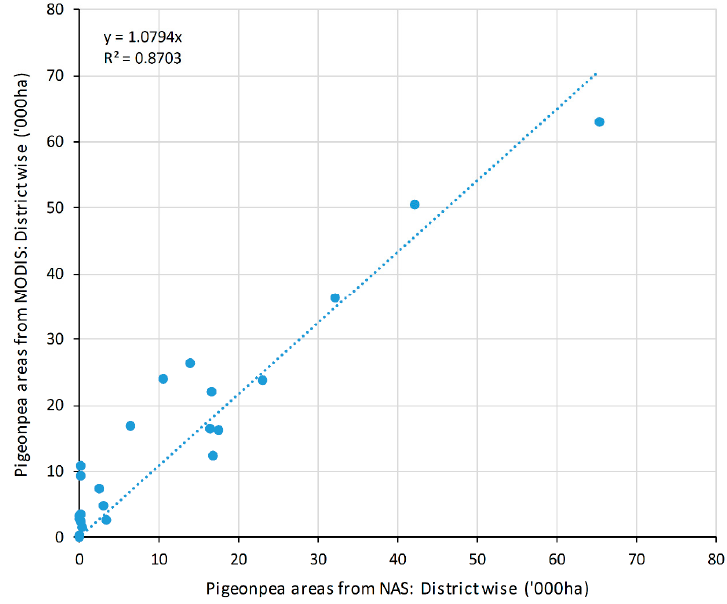
Figure 6. District-level pigeonpea areas derived using MODIS time series data compared with national statistics data for the agricultural year 2016–2017.